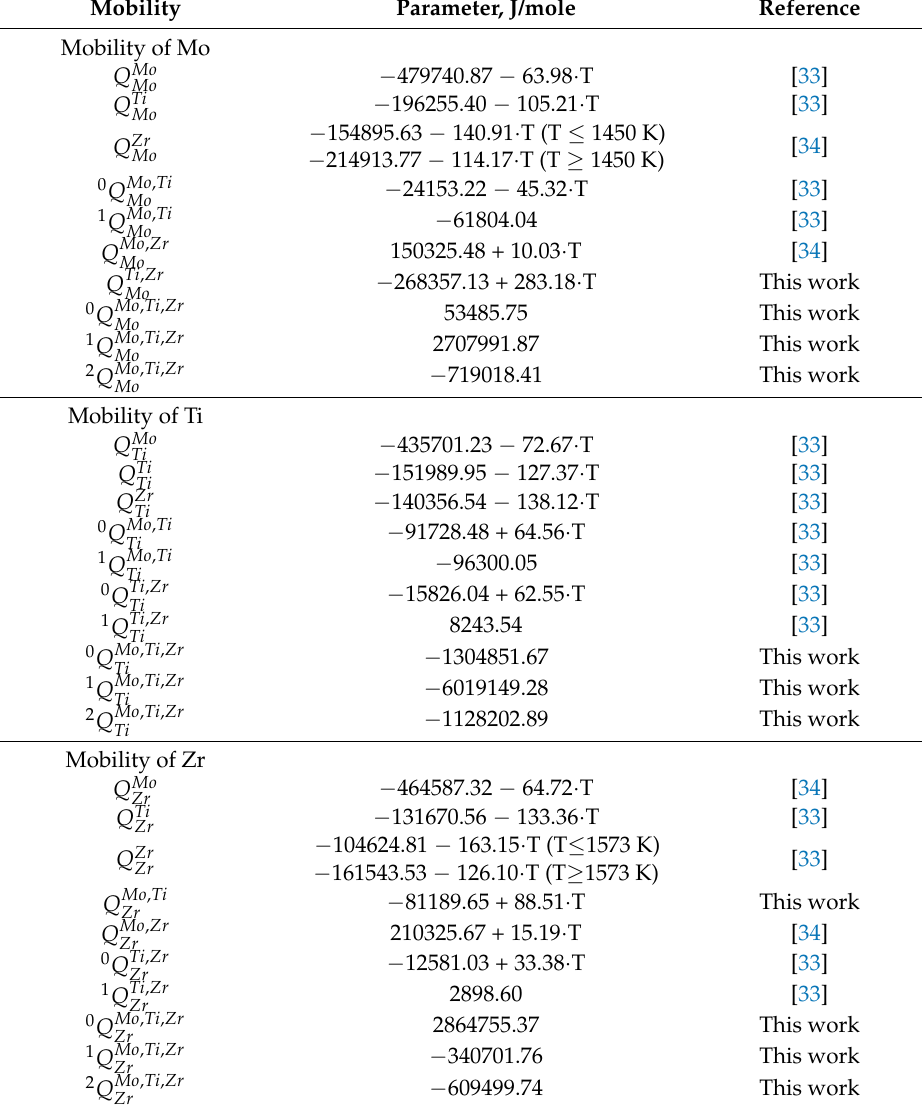
Table 4. Atomic mobility parameters for the bcc phase of the Ti-Mo-Zr ternary